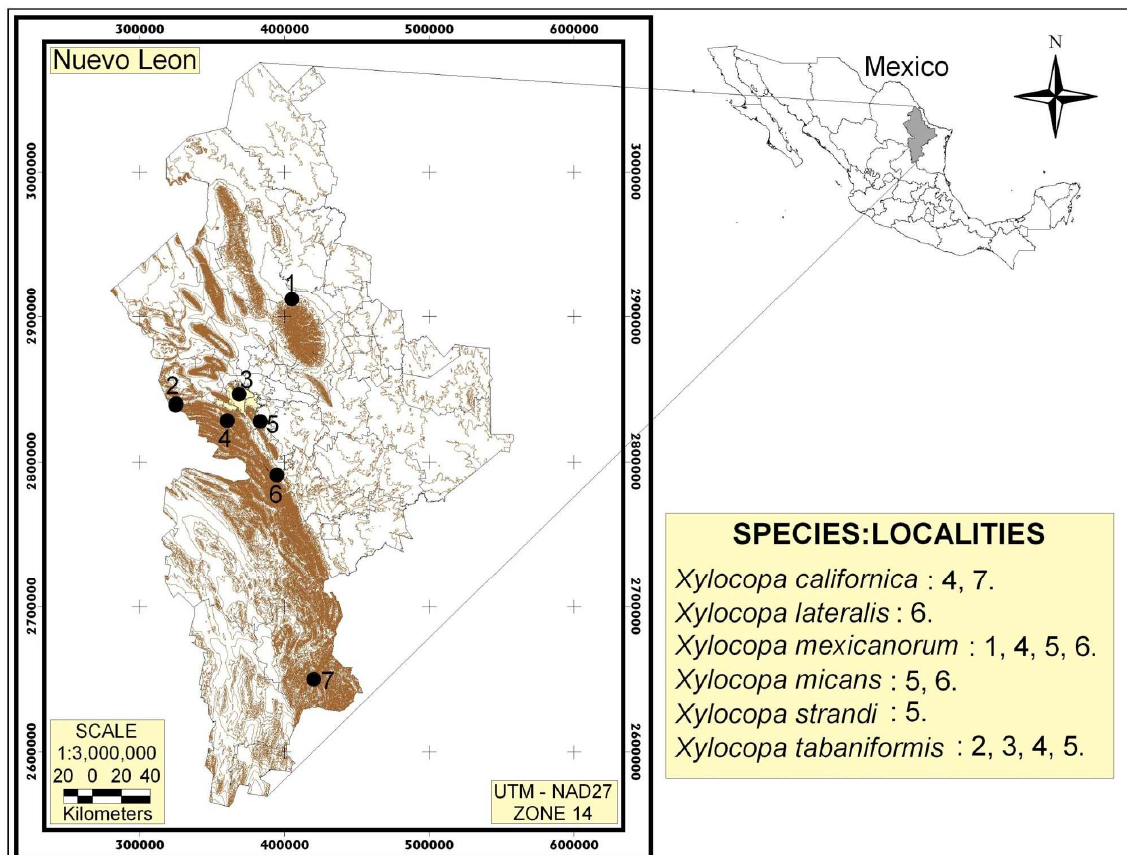
Figure 1. Sampling sites and distribution of Xylocopa species at Nuevo Leon,